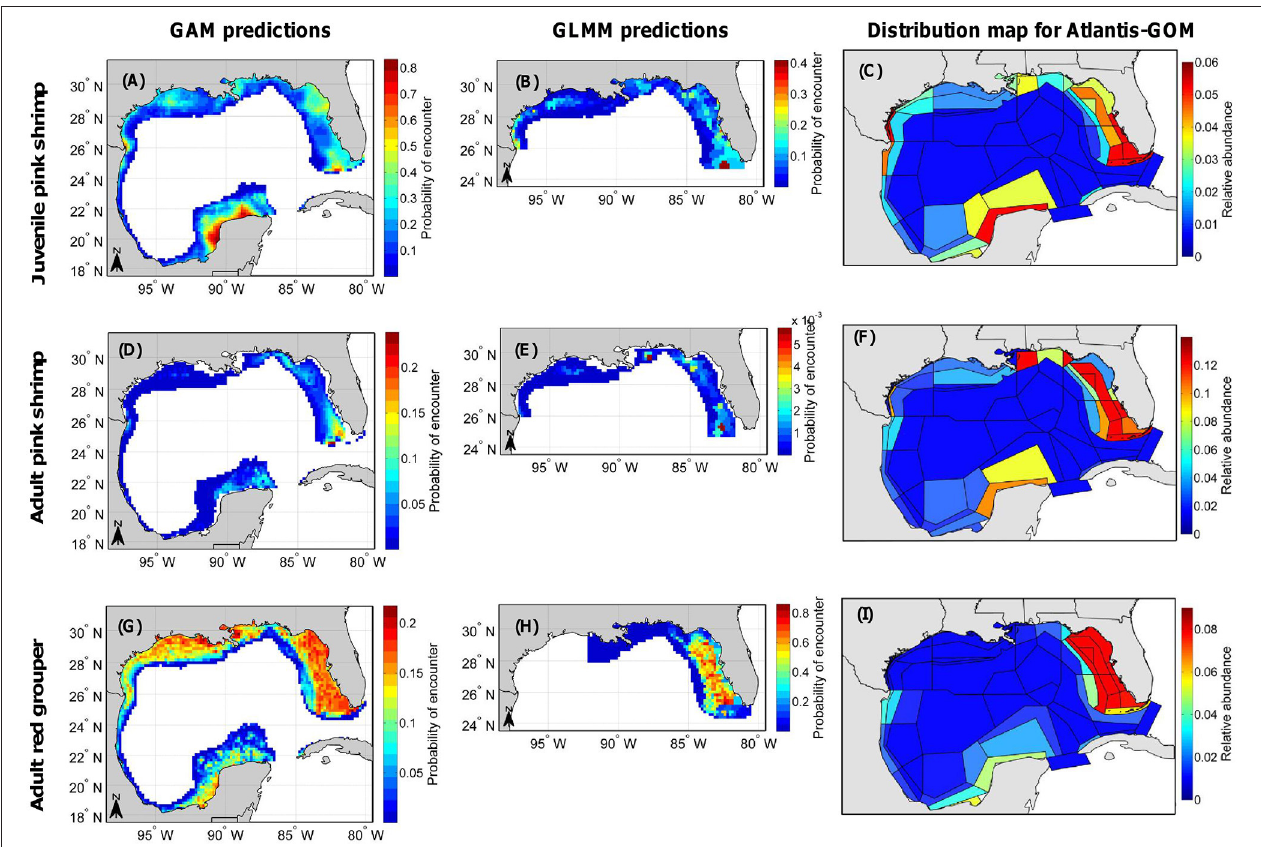
FIGURE 4 | Distribution maps produced for (A–C) juvenile pink shrimp ( Farfantepenaeus duorarum ), (D–F) adult pink shrimp, and (G–I) adult red grouper ( Epinephelus morio ). (A,D,G) are probability of encounter maps for the entire Gulf of Mexico Large Marine Ecosystem generated from the predictions of generalized additive models (GAMs). (B,E,H) are probability of encounter maps for the U.S. Gulf of Mexico generated from the predictions of geostatistical generalized linear mixed models (GLMMs). Finally, (C,F,I) are maps of relative abundance usable in the Atlantis-GOM ecosystem model (such that the sum of relative abundances for each map is equal to